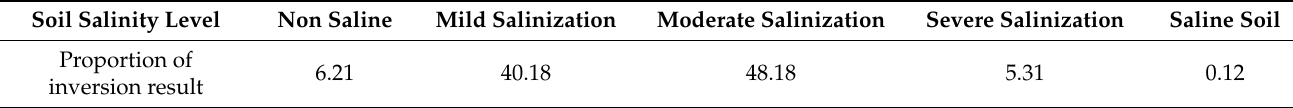
Figure 9. Inversion results based on satellite-UAV-ground integration. Table 7. Statistics of soil salinity grade area in corn area (Unit: %).